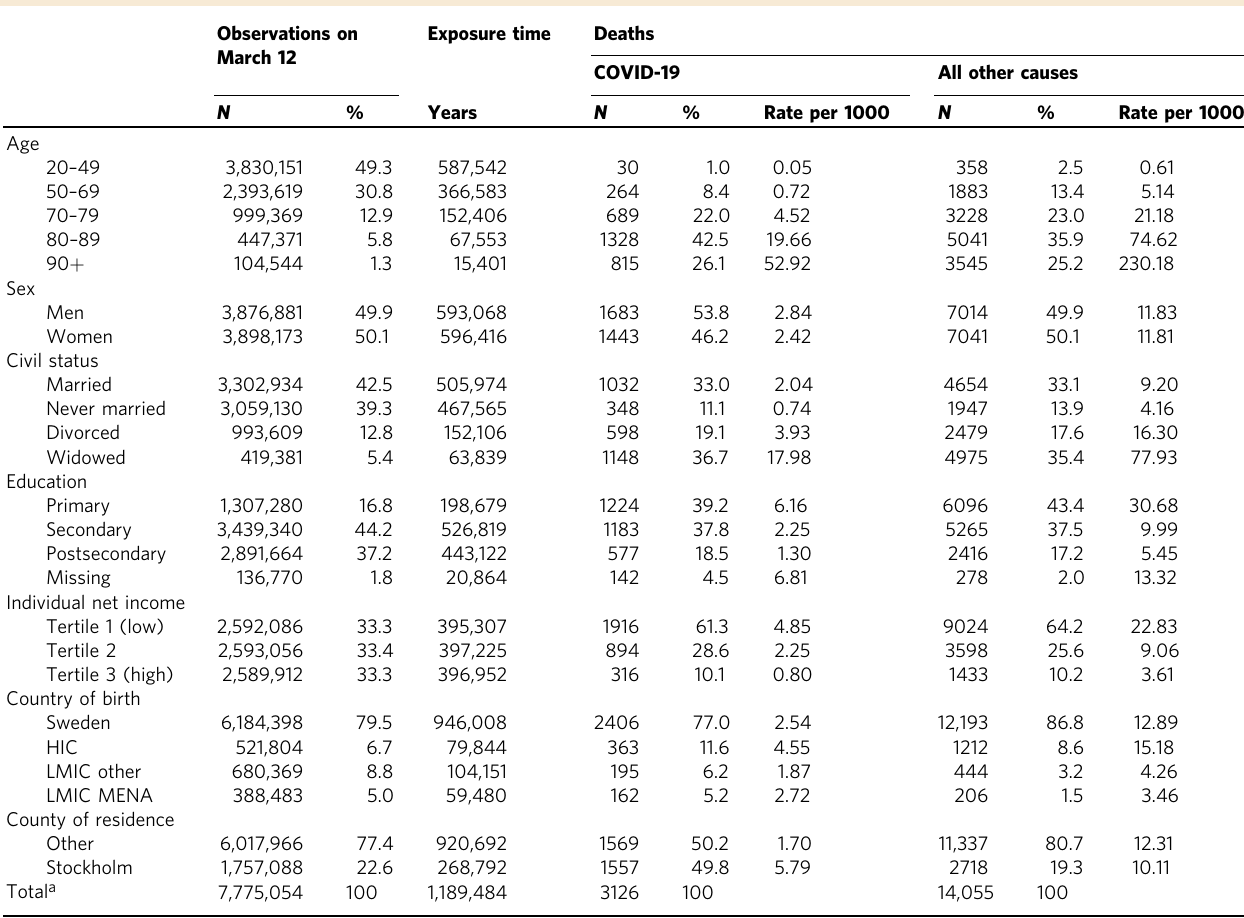
Table 1 Observations, deaths, and exposure time to the risk of death from COVID-19, and all other causes of death in